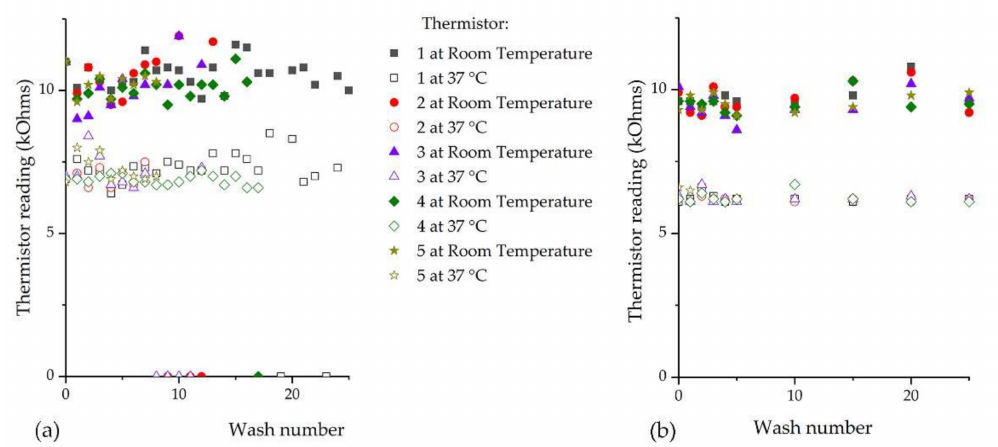
Figure 6. Readings from thermistors at room temperature (19.5–25.7 ◦ C) and at 37 ◦ C after machine washing with: ( a ) tumble-drying; ( b ) line drying. Symbols are not shown after the E-yarns physically broke.